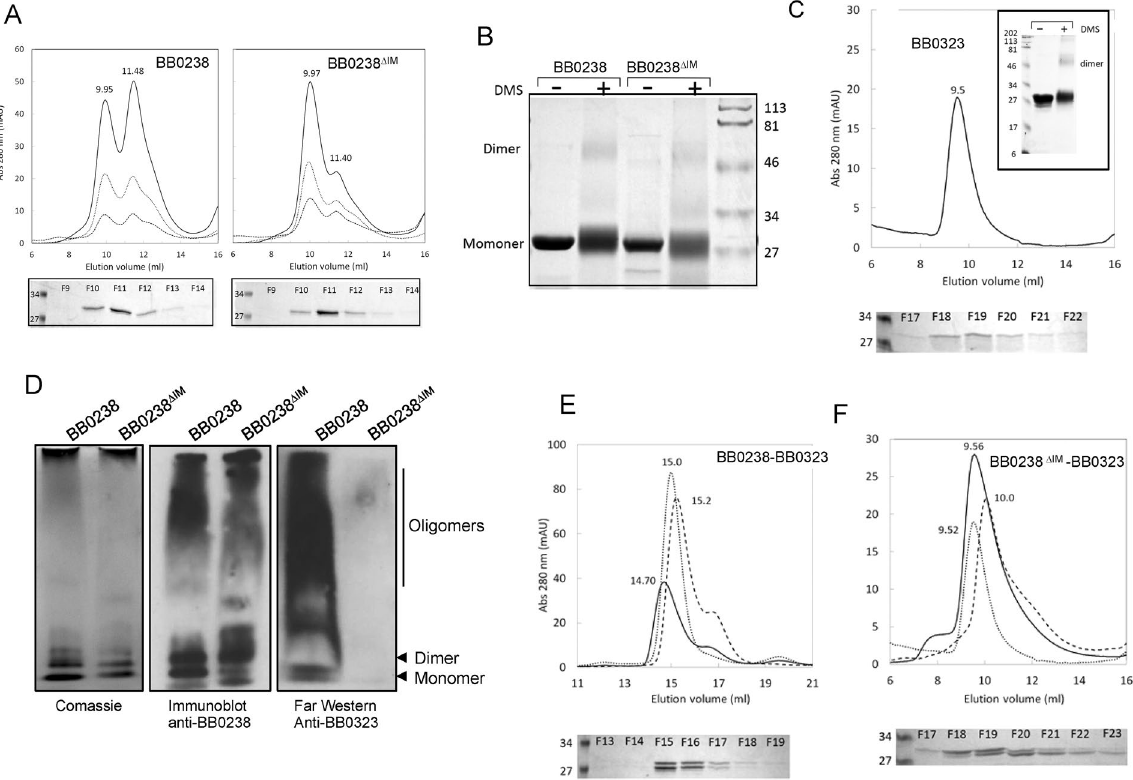
Figure 3. Homo- and hetero-oligomerization of BB0323 and BB0238 in the presence and absence of BB0238 11-residue interaction region. ( A ) Quaternary structure of BB0238 and BB0238 ∆ IM as assessed by analytical size exclusion chromatography. Elution profiles of various concentrations of proteins, 9 μ M (dashed line), 18 μ M (dotted line) and 44 μ M (solid line) BB0238 (left panel) and 10 μ M (dashed line), 20 μ M (dotted line) and 40 μ M (solid line) BB0238 ∆ IM (right panel) from Sephadex 75 column. Lower panels show coomassie-stained denaturing SDS-PAGE of the eluted fractions F9-F14 from the experiments using 44 μ M BB0238 or 40 μ M BB0238 ∆ IM . ( B ) BB0238 Cross-linking studies. Coomassie-stained denaturing SDS-PAGE of ~9 μ M BB0238 and BB0238 ∆ IM cross-linked with DMS as described in Materials and Methods. Lanes labeled ( − ) and ( + ) correspond to proteins that were treated with 1 M Triethanolamine buffer alone or with DMS, respectively. The right lane shows molecular weight markers. ( C ) Quaternary structure of BB0323 (residues 22–242) as assessed by analytical size exclusion chromatography. Elution profiles of 8 μ M BB0323 from Superdex 75 column. Bottom panel showed coomassie blue-stained denaturing SDS-PAGE of BB0323 N2 in 0.5 mL fractions collected. Inset: Coomassie blue-stained denaturing SDS-PAGE of ~19 μ M BB0323 crosslinked with DMS as described in Materials and Methods. BB0323 in the negative control ( − ) and positive ( + ) lanes were treated with 1 M Triethanolamine buffer alone or with DMS, respectively. ( D ) One dimensional PAGE separation of native BB0238 and BB0238 ∆ IM . Gel separations were stained with Comassie Brilliant Blue (left panel), immunoblotted with anti-BB0238 antibody (middle panel) and subjected to far-Western analysis using anti-BB0323 antibody (right panel). ( E ) Elution profiles of 10 μ M BB0238- BB0323 complex at ~1:1 molar ratio (solid line), 30 μ M BB0323 (dotted line) and 40 μ M BB0238 (dashed line) from Superdex 200 column with 1 mL fractions collected. ( F ) Elution profiles of ~9 μ M BB0238 ∆ IM -8 μ M BB0323 22-242 complex (solid line), 8 μ M BB0323 (dotted line) and 9 μ M BB0238 ∆ IM (dashed line) from Superdex 75 column with 0.5 mL fractions